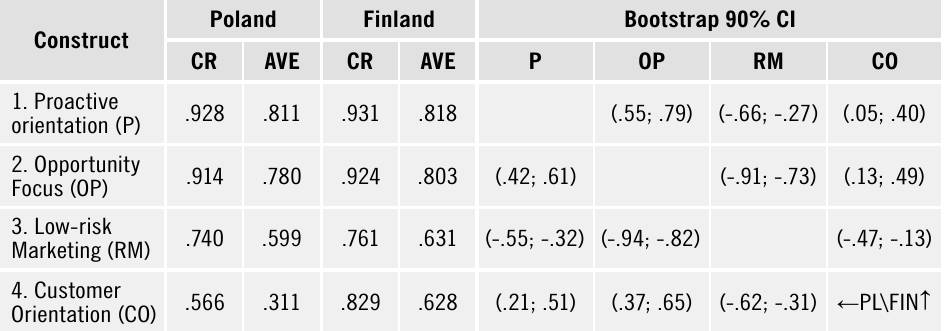
Table 3. Scales’ properties of EMO dimensions